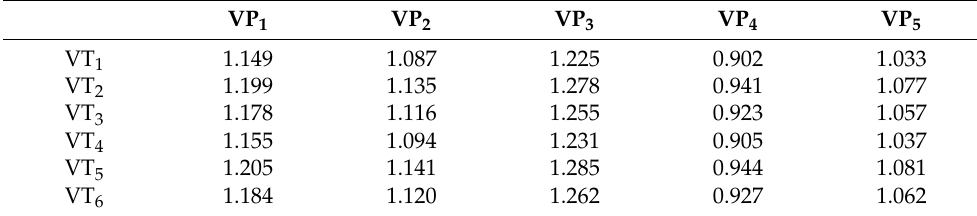
Table 8. Average values of correspondence between VT i and VP j in the second approach of the analysis.